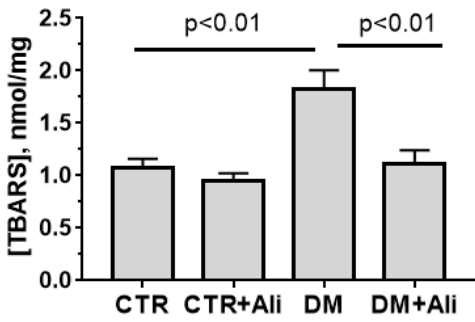
Figure 4. Alisporivir significantly suppresses the DM-induced lipid peroxidation in mouse heart mitochondria. Lipid peroxidation was assessed by the level of TBARS in the heart mitochondria of experimental groups of animals. Values are given as means ± SEM (n = 5).